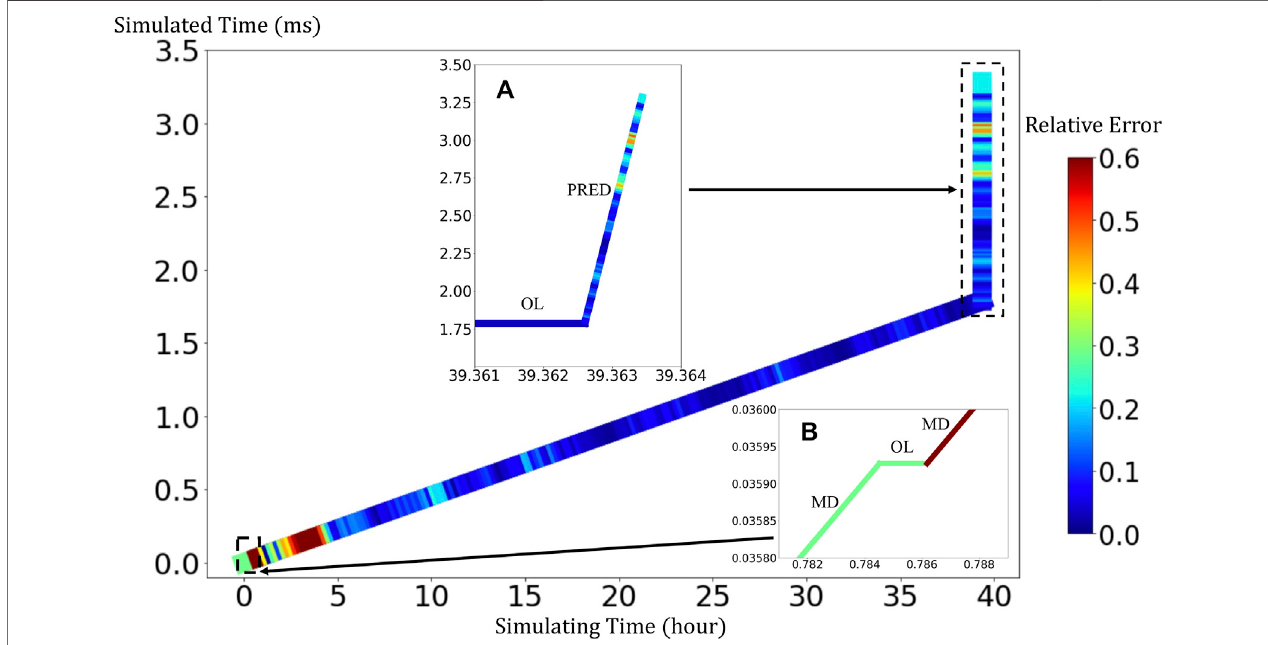
FIGURE10| Quantitativeanalysisofourintegratedmethods.Speedismeasured bysimulatedtimeoversimulatingtimesothatalargerslopemeansfasterspeed. Relative errors at different steps are expressed ina standard RGB color bar.Taking example datafrom rigid platelet at 300 dyne/cm 2 .MD refers tomoleculardynamics, OL refers to online learning and PRED denotes predictions from BIOL. Part (A) and Part (B) are two ampli fi ed regions.